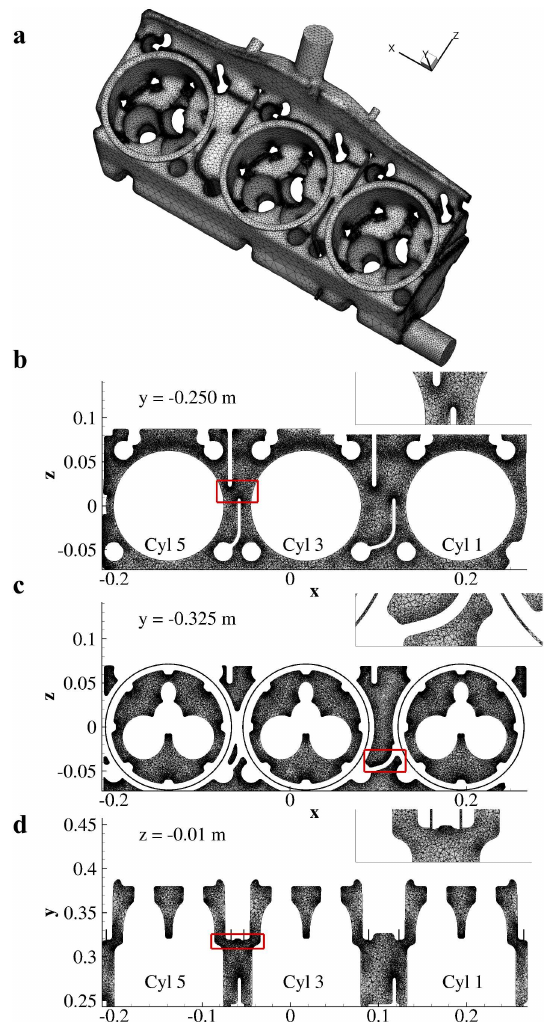
Figure 2. Spatial discretization of the cooling system for the single-inlet configuration. ( a ) Computational mesh of the right bank of the cooling system. ( b , c ) Transversal sections of the computational mesh at ( b ) y = − 0.250 m and ( c ) y = − 0.325 m. ( d ) Longitudinal section of the computational mesh at the valve plane z = − 0.01